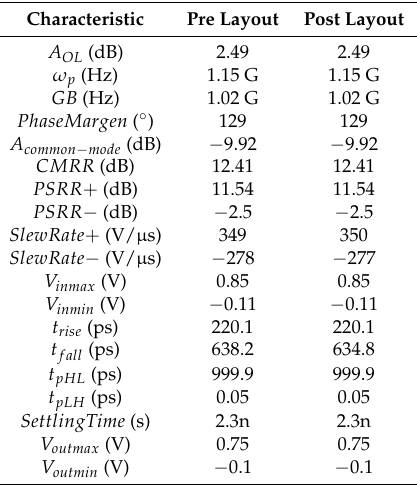
Table 5. Pre- and post-layout characterization of the CMOS differential